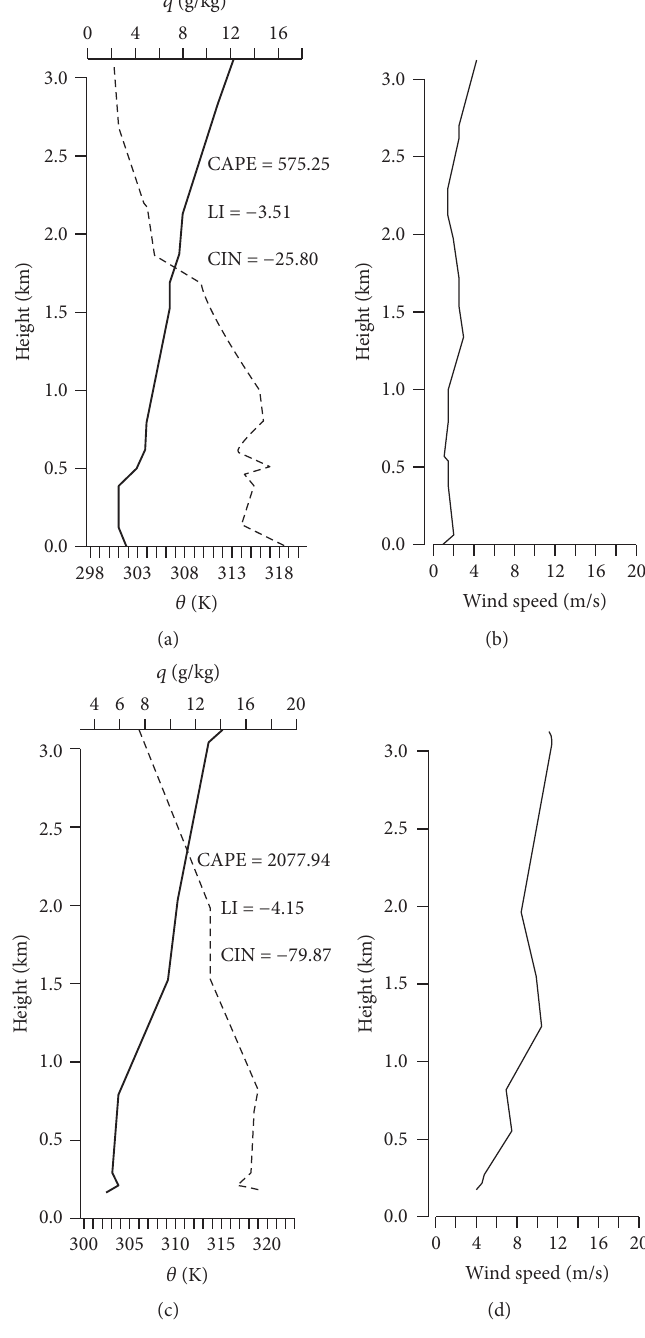
Figure 11: Same as in Figure 6 but for profiles observed at 12Z 18 January 2010 for ((a)-(b)) SBPA and ((c)-(d)) SBFI.